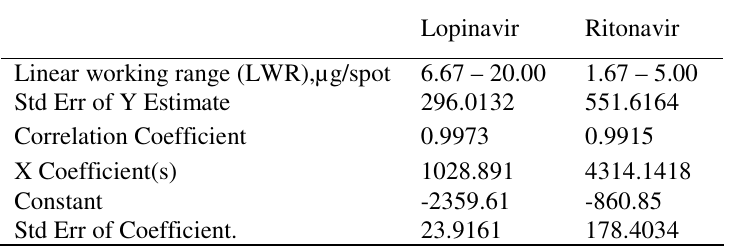
Table 1. Analytical Performance